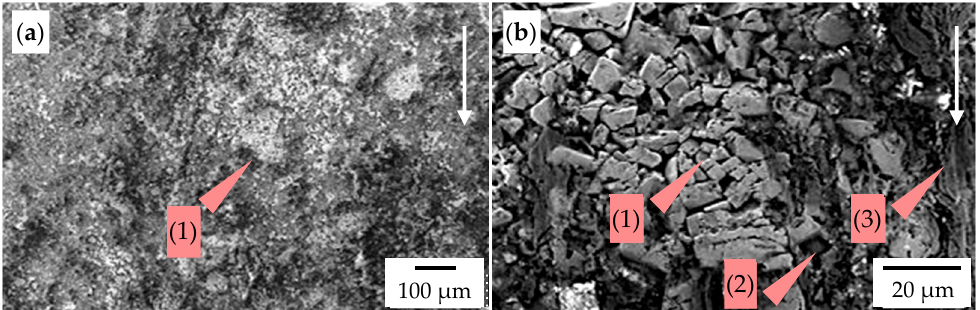
Figure 13. The worn surface of the cemented-carbide plate operating in the soil: chisel A, zone Z1 indicated in Figure 5; the white arrow presents the direction of the impact of soil particles. ( a ) Visible pits (1) caused by chipping out of tungsten carbide (WC) grains from the cobalt matrix and ( b ) visible crushed WC grains (1), pits (2), and traces of the interaction of soil particles in the cobalt matrix (3). SEM, SE detector.